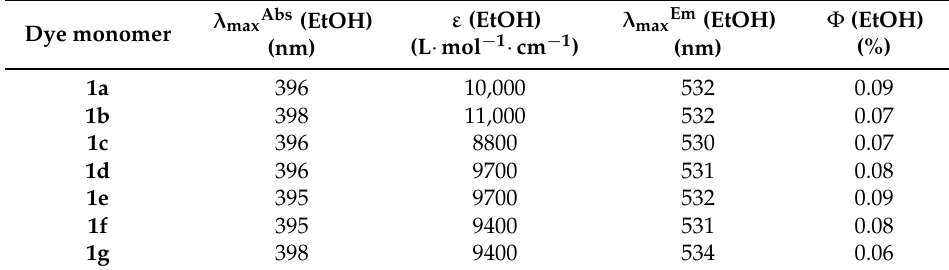
Table 2. Photophysical characteristics of dye monomers 1a - 1g in ethanol (21 ˝ C).